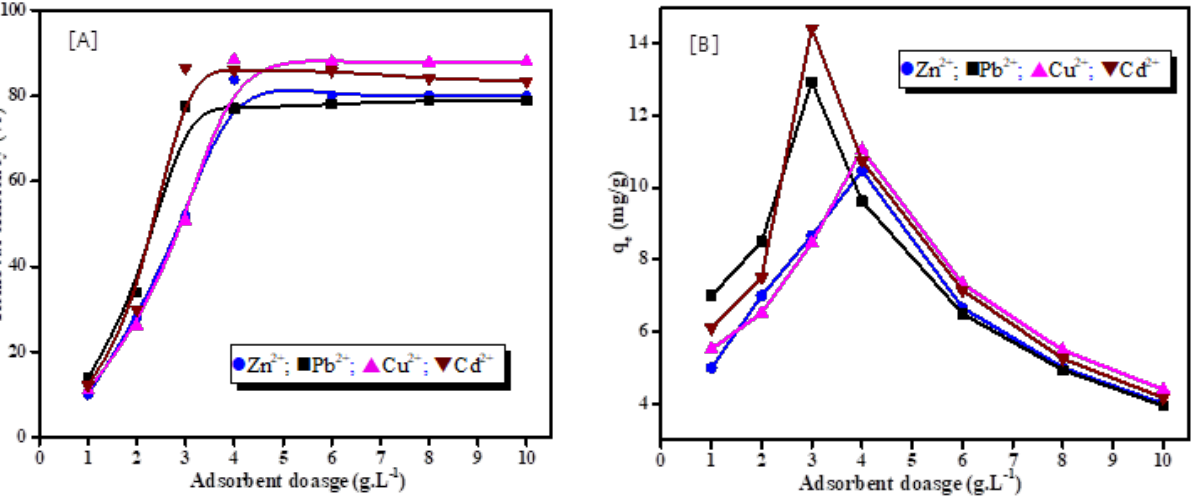
Figure 6. Effect of adsorbent dosage on heavy metal ions removal efficiency ( A ), adsorption capacity of heavy metal ions on synthesized zeolite ( B ).